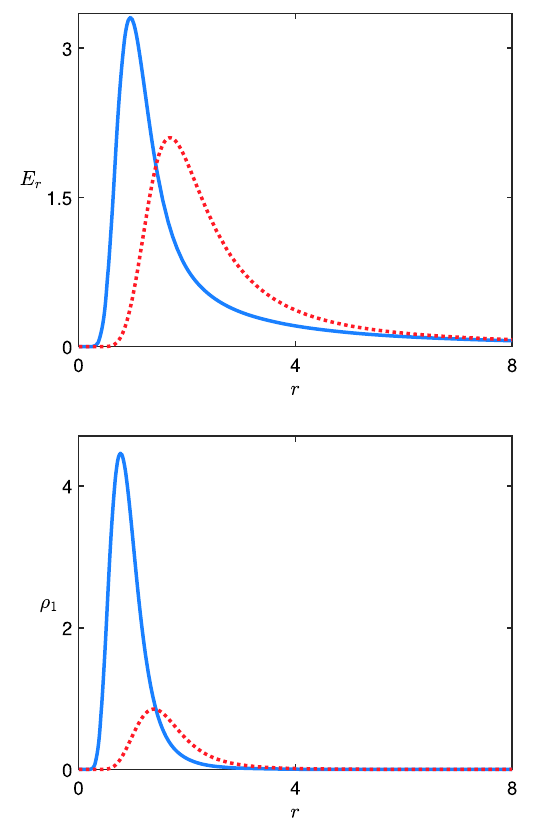
Fig. 16 The radial component of the electric field (top) with e = 1 and the energy density (bottom) associated to the model in Sect. 4.2.1 for σ = 5, α = 2, and k = 1 (solid, blue line) and 2 (dotted, red line)